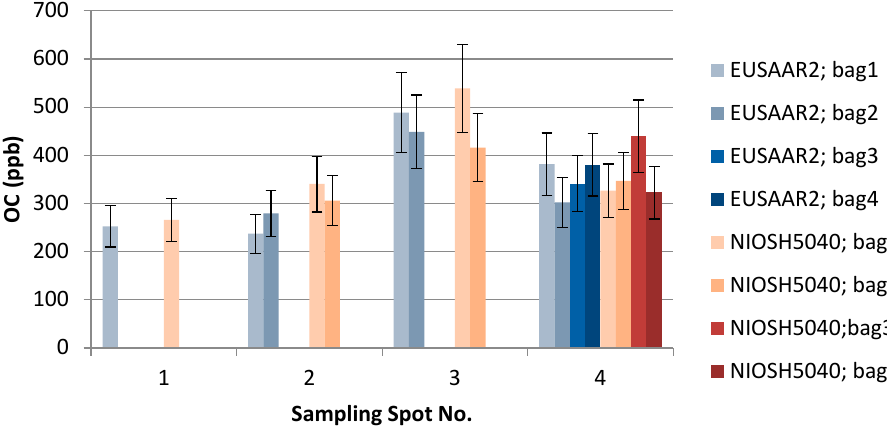
Sampling Spot No. Figure 5. The effect of EUSAAR2 and NIOSH5040 analysis protocols on the detected EC.